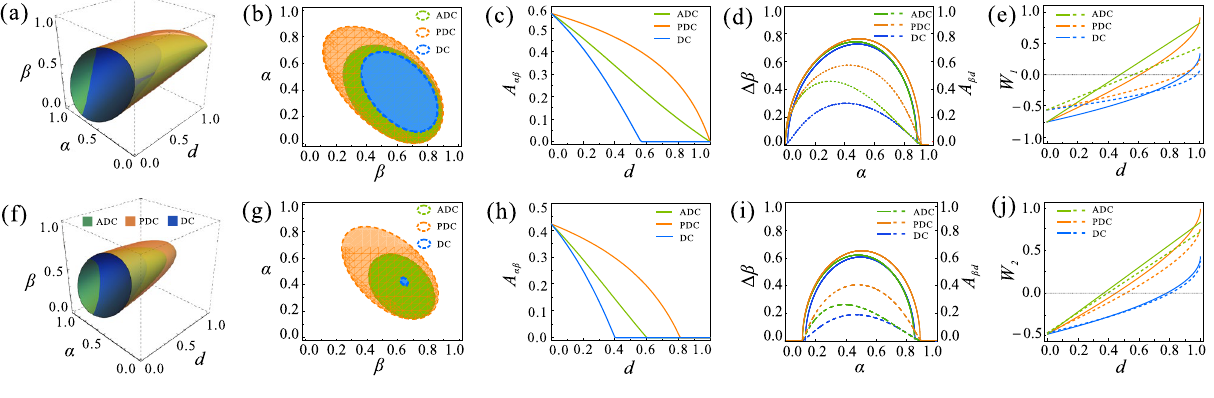
Figure 1. Upper panel: The effects of different decoherence channels on the dynamics of 1SDI genuine tripartite steering. ( a ) The steerable regions are parameterized by decoherence strength d and state parameters α , β . The regions enclosed by the green, orange, and blue surfaces correspond to the existence of 1SDI genuine } { tripartite steering in ADC, PDC, and DC, respectively. ( b ) The sectional views of ( a ) when d area of steerable state parameters A αβ as a function of decoherence strength d . ( d ) The maximum steerable state parameter range �β and the area of steerable region A β d as a function of state parameter α . ( e ) The 1SDI genuine tripartite steering parameter W 1 as a function of decoherence strength d . Bottom panel: same as upper column but in the case of 2SDI scenario. The results of ADC, PDC, and DC are displayed in green, orange, and blue in turn. The solid lines and dashed lines shown in ( d,i ) correspond to �β and A β d , respectively. The solid lines and dashed lines shown in ( e ) correspond to α solid lines and dashed lines shown in ( j ) correspond to α